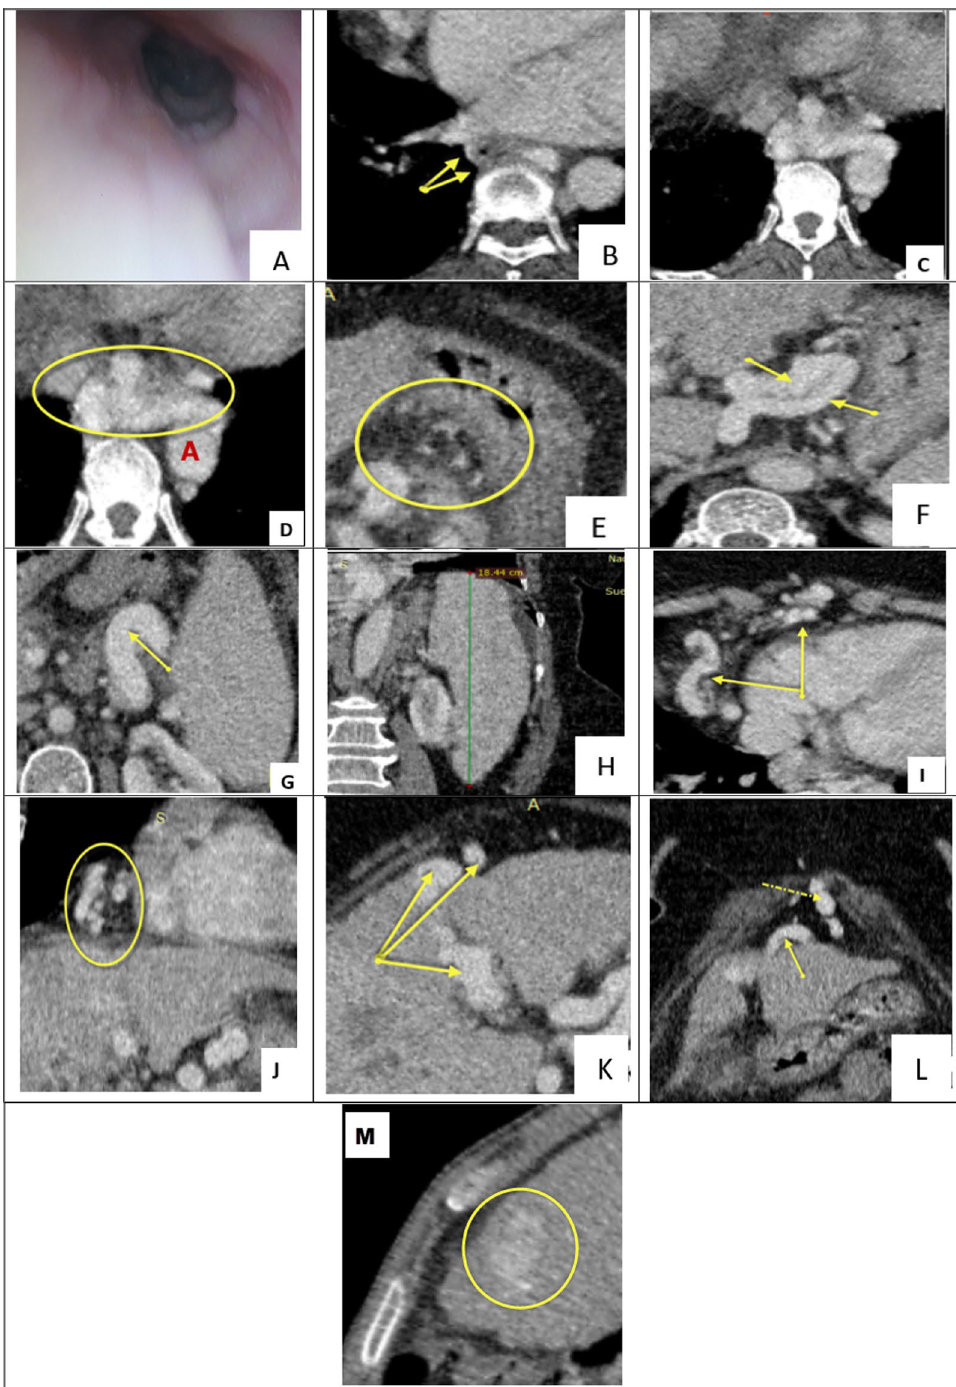
Fig. 7 A 60-year-old female patient with chronic liver disease and esophageal varices on follow-up after esophageal varices band ligation. Upper GI endoscopy was done for variceal scanning, and triphasic MDCT scan was done for HFL scanning. A Upper GI endoscopy shows obliterated varices. Axial CT shows the following; B no esophageal varices (solid arrow), C , D dilated paraesophageal varices grade IV (oval region); letter A denotes Aorta, E retrogastric (adventitial) varices (round region), F , G markedly dilated and tortuous both left gastric (coronary) varix (solid arrows)in F , and splenic vein in G , H heterogeneous enhancing lesion in the right lobe of the liver, suggestive of a HFL lesion. Both I , J show right dilated, tortuous cardiophrenic varices, where appeared in Axial CT in figure ( I ) (solid arrows), and in Coronal CT in figure ( J ) (oval region). K Axial CT shows left hepatic shunt (arrow), L Coronal CT shows left hepatic shunt (solid arrow), ascending left supradiaphragmatic varix piercing the left diaphragm to reach the chest (dashed arrow). M Axial CT shows enhanced hepatic focal lesion appeared in arterial phase (round